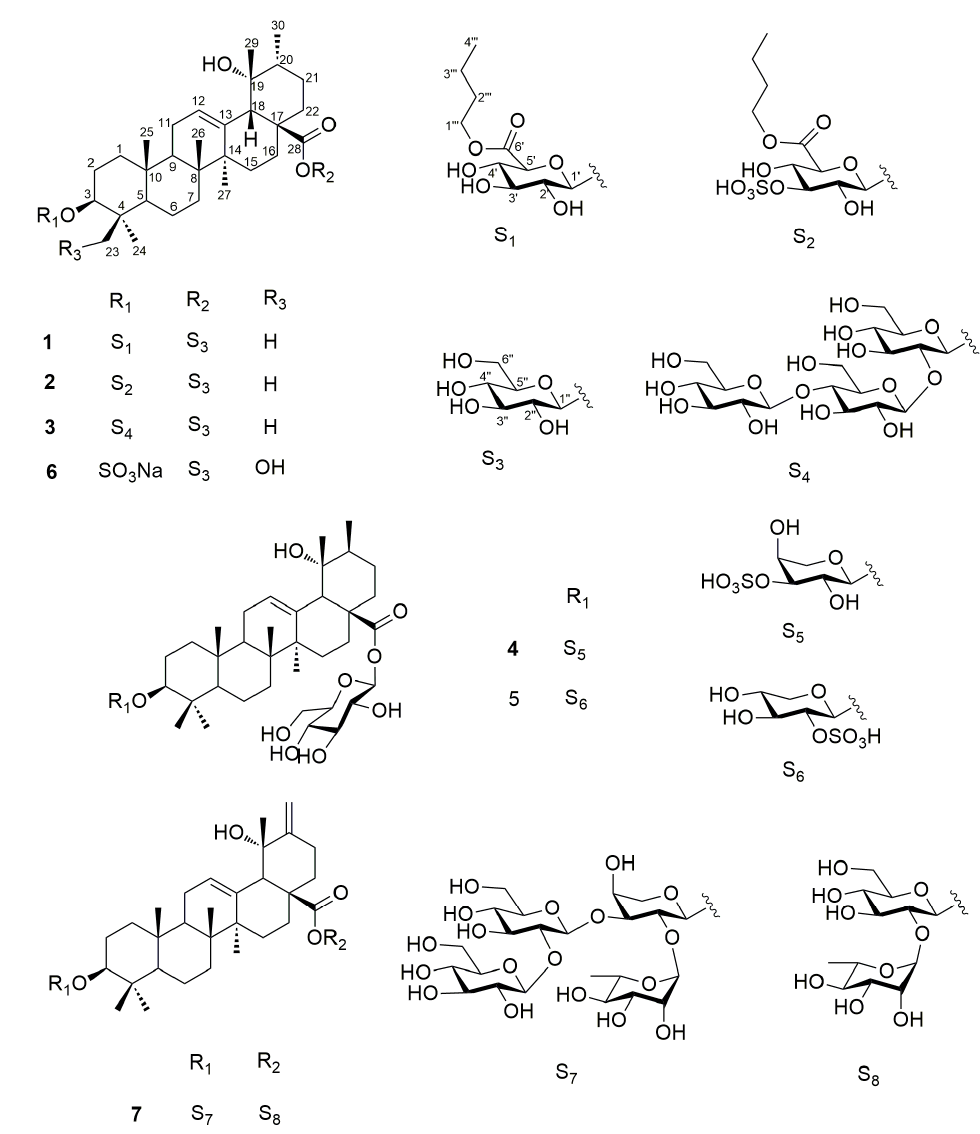
Figure 1. Structures of compounds 1 – 7 .